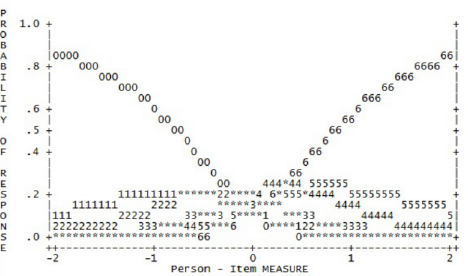
Fig 1. Response probability curve with original 7-point response options (Factor 5).